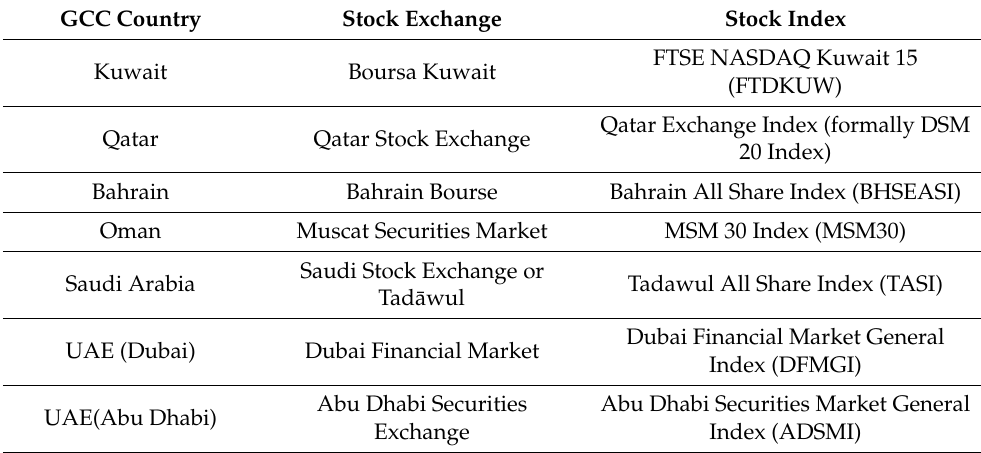
Table 1. The List of Gulf Cooperation Council countries and the Stock Exchanges. GCC Country Stock Exchange Stock